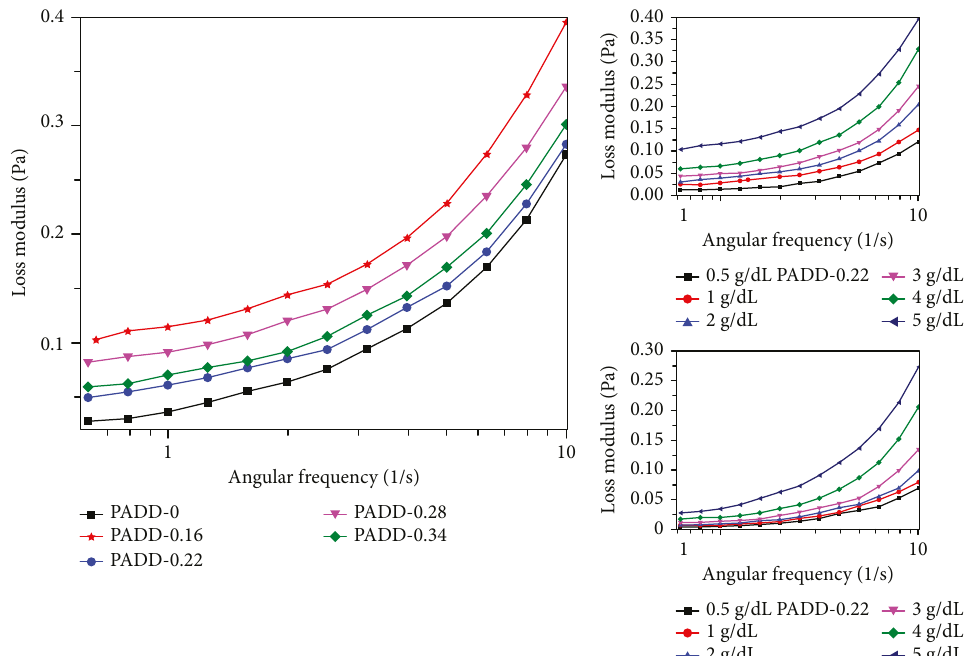
Figure 4: Variation of loss modulus of polymer solutions in brine (25.0 ± 0.1 ° C; 5 g/dL polymer).